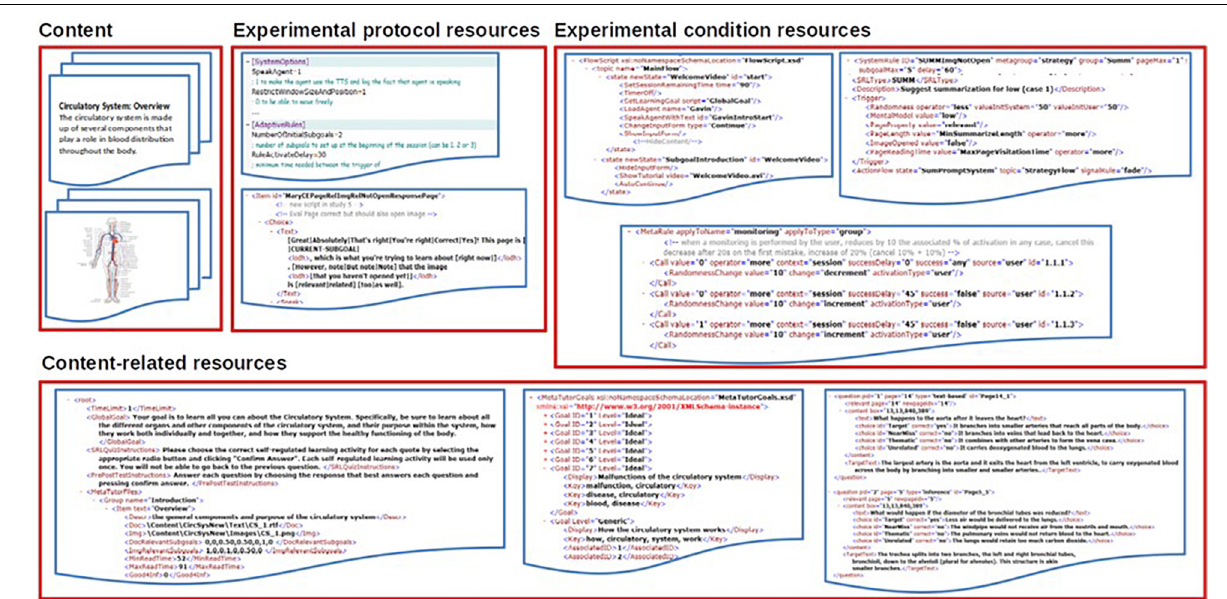
FIGURE 4 | MetaTutor’s overall